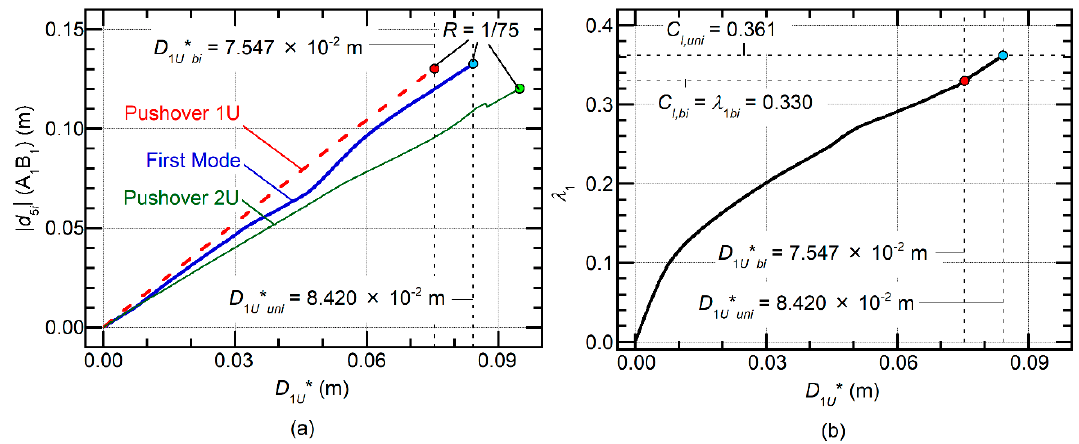
Figure 21. Evaluation of the capacity index considering the bidirectional ground motion C I, bi : ( a ) roof displacement responses at column A 1 B 1 and ( b ) variation of the scale factor λ .